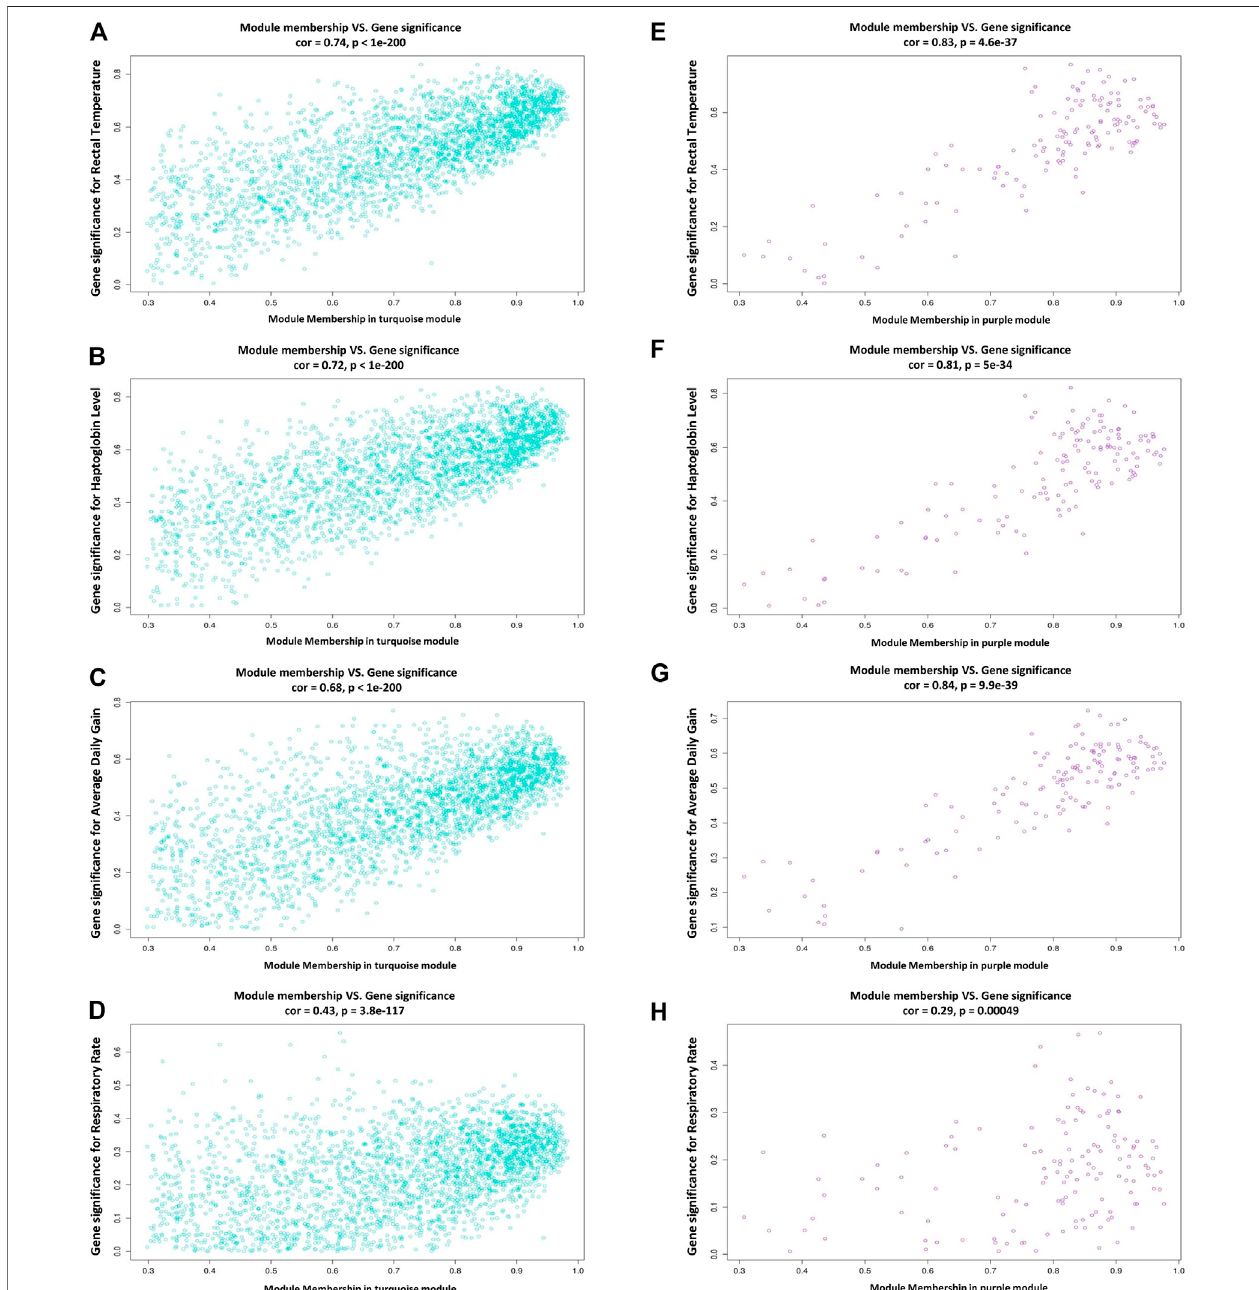
FIGURE 5 | Scatterplots of module membership (MM) versus gene signi fi cance (GS) plots. (A – D) module membership versus gene signi fi cance for rectal temperature, haptoglobin level, average daily gain, and respiratory rate in the turquoise module, respectively. (E – H) module membership versus gene signi fi cance for rectal temperature, haptoglobin level, average daily gain, and respiratory rate in the purple module, respectively.